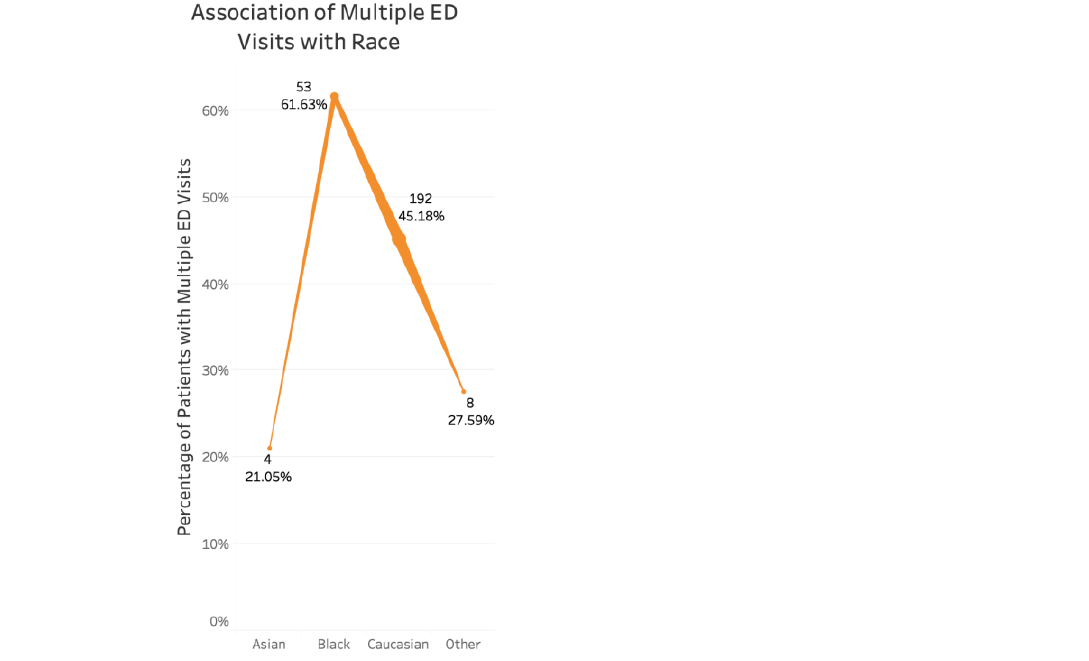
Figure 5. Association of multiple ED visits with race. There was a significant association between race and multiple visits, with Blacks ( p = 1.69 × 10 − 8 , coefficient 0.439) and Caucasians ( p = 3.66 × 10 − 5 , coefficient 0.310) comprising the majority of these visits. Line thickness indicates the number of visits, with thicker lines representing more total visits.